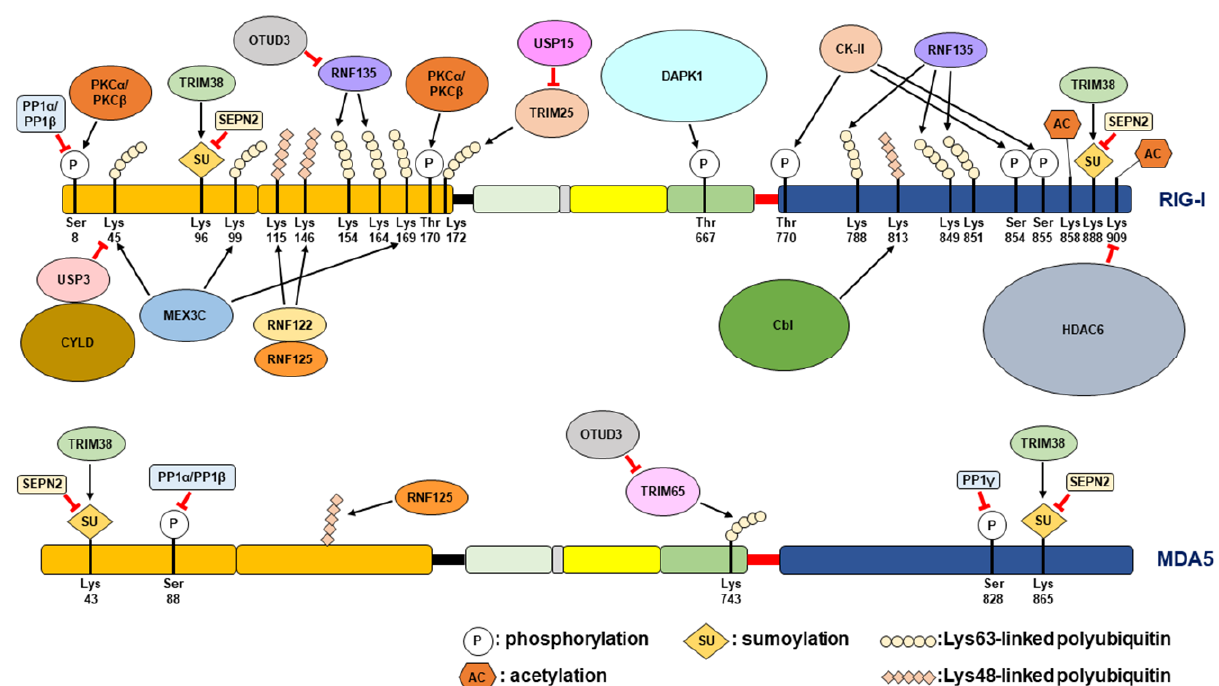
Figure 2. Post-translational modifications (PTMs) of RLR signaling molecules: RIG-I and MDA5 are regulated by phosphorylation, dephosphorylation, acetylation, deacetylation, ubiquitination, and deubiquitination and modified by Lys-48- and Lys-63-linked polyubiquitin. The enzymes responsible for PTMs are illustrated, and the modified amino acid residues are specifically indicated. PKC- α , Protein kinase C- α ; PKC- β , Protein kinase C- β ; TRIM25, tripartite motif 25; TRIM38, tripartite motif 25; TRIM65, tripartite motif 65; CK-II, casein kinase II; DAPK1, death-associated protein kinase 1; PP1 α , protein phosphatase 1 α ; PP1- γ , protein phosphatase 1 γ ; HDAC6, histone deacetylase 6; SENP2, sentrin/SUMO-specific protease 2; RNF122, RING finger protein 122; RNF125, RING finger protein 125; RNF135, RING finger protein 135; MEX3C, mex-3 RNA binding family member C; Cbl, casitas B-lineage lymphoma proto-oncogene; USP4, ubiquitin-specific protease 4; USP15, ubiquitin-specific protease 15; CYLD, CYLD lysine 63 deubiquitinase; OTUD3, ovarian tumor protease deubiquitinating enzyme 3.